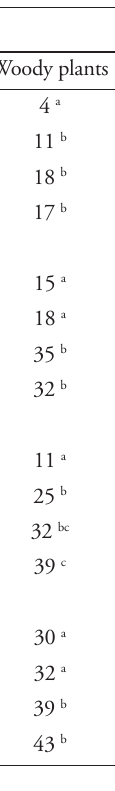
Table 1. Percentage of ground cover in each treatment. Means within the same ground cover type and date of observation, followed by the same letter are not significantly different at p ≤ 0.05 (n =